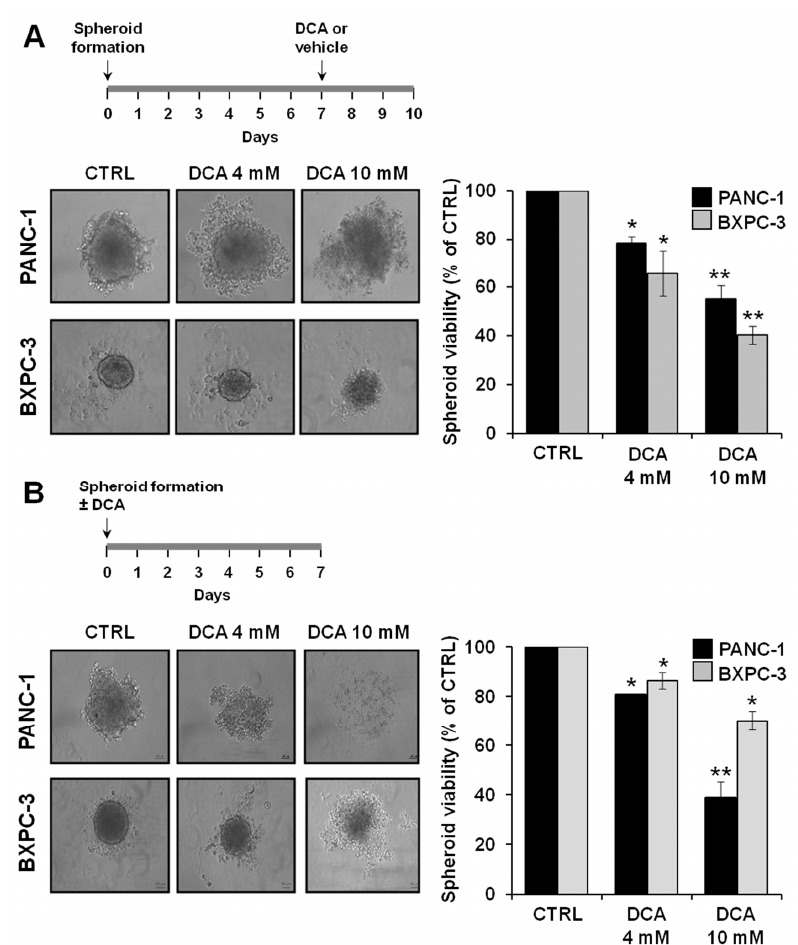
Figure 8. E ff ect of DCA on 3D culture from PANC-1 and BXPC-3 cells, ( A ) representative images of 3D culture obtained from PANC-1 (upper panel) and BXPC-3 (lower panel) seeded into ultra-low attachment plates, cultured for 7 days to obtain spheroid and treated with DCA 4 mM and DCA 10 mM for 72 h, spheroid viability (expressed as a percentage value compared to untreated condition) measured by MTS assay, * p < 0.05, ** p < 0.01 vs. CTRL; ( B ) inhibition of spheroid formation from PANC-1 and BXPC-3 cells treated with 4 mM DCA and 10 mM DCA treatment for 7 days, cell suspension of 1000 cells was seeded into ultra-low attachment plates and treated with DCA, spheroid viability (expressed as a percentage value compared to untreated condition) was measured by MTS assay; * p < 0.05, ** p < 0.01 vs. CTRL.